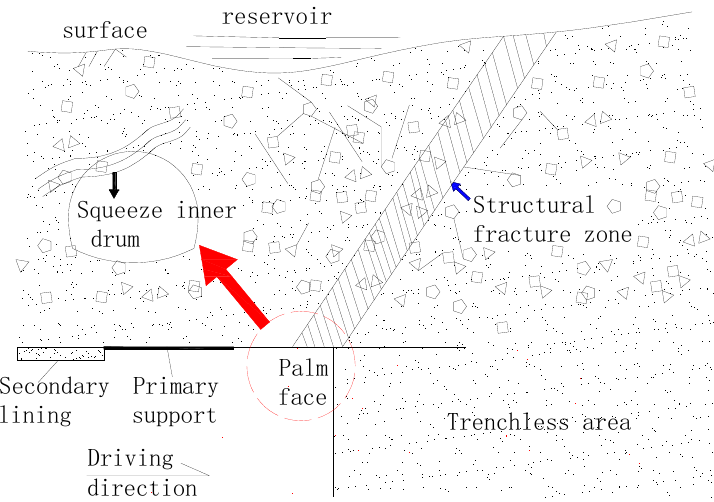
Figure 3. General model of tunnel surrounding rock instability.